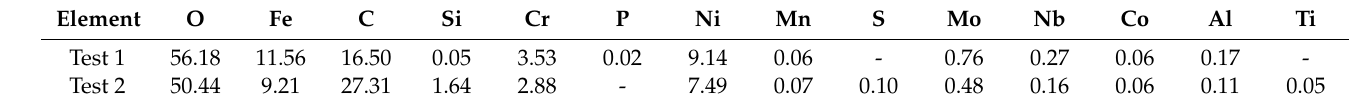
Table 9. Fe-based EDS spot scan of atoms for each element content (wt%).